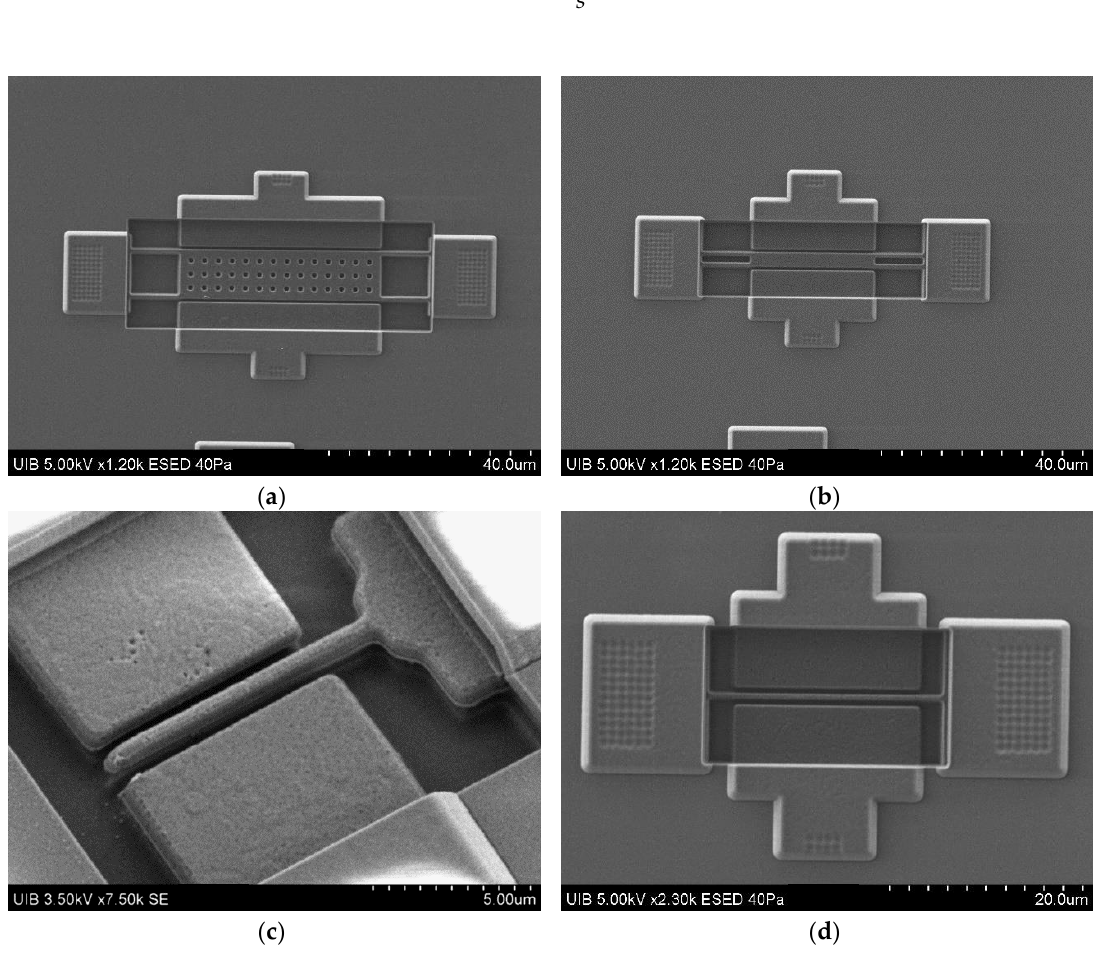
Figure 3. Scanning electron microscopy (SEM) images of the resonators with the driver and readout electrodes fabricated using the top metal layer of the 0.35- μ m technology. ( a ) Plate-B1 resonator with a 41 μ m × 10 μ m platform, ( b ) Plate-B2 resonator with a 25 μ m × 3 μ m platform, (c) 10 μ m long Cantilever, and ( d ) and 25 μ m long CC-beam.